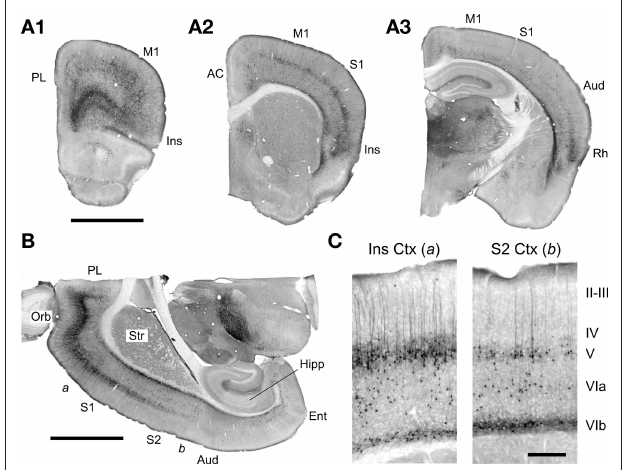
Figure 1 | egFP expression in the forebrain of the 5-HT r-egFP mouse. 2A (A,B) Low magnification images illustrating the distribution of EGFP expressing cells in coronal and horizontal sections. Calibration bar = 2 mm. AC, anterior cingulate cortex; Aud, auditory cortex; Ent, Entorhinal cortex; Hipp, hippocampus; Ins, insular cortex; M1, primary motor cortex; Orb, orbital cortex; PL, prelimbic cortex; Rh, rhinal cortex; S1, primary somatosensory cortex; S2, secondary somatosensory cortex, Str, striatum. Low magnification images of parasagital brain sections for this mouse are available at the GENSAT web site. (C) Higher magnification images depicting the EGFP immunoreactivity in the insular [ a in (B) ] and secondary somatosensory cortex [ b in (B) ]. Calibration bar = 250 μm. In this figure EGFP was immunolocalized using a rabbit anti-GFP antibody and detected using